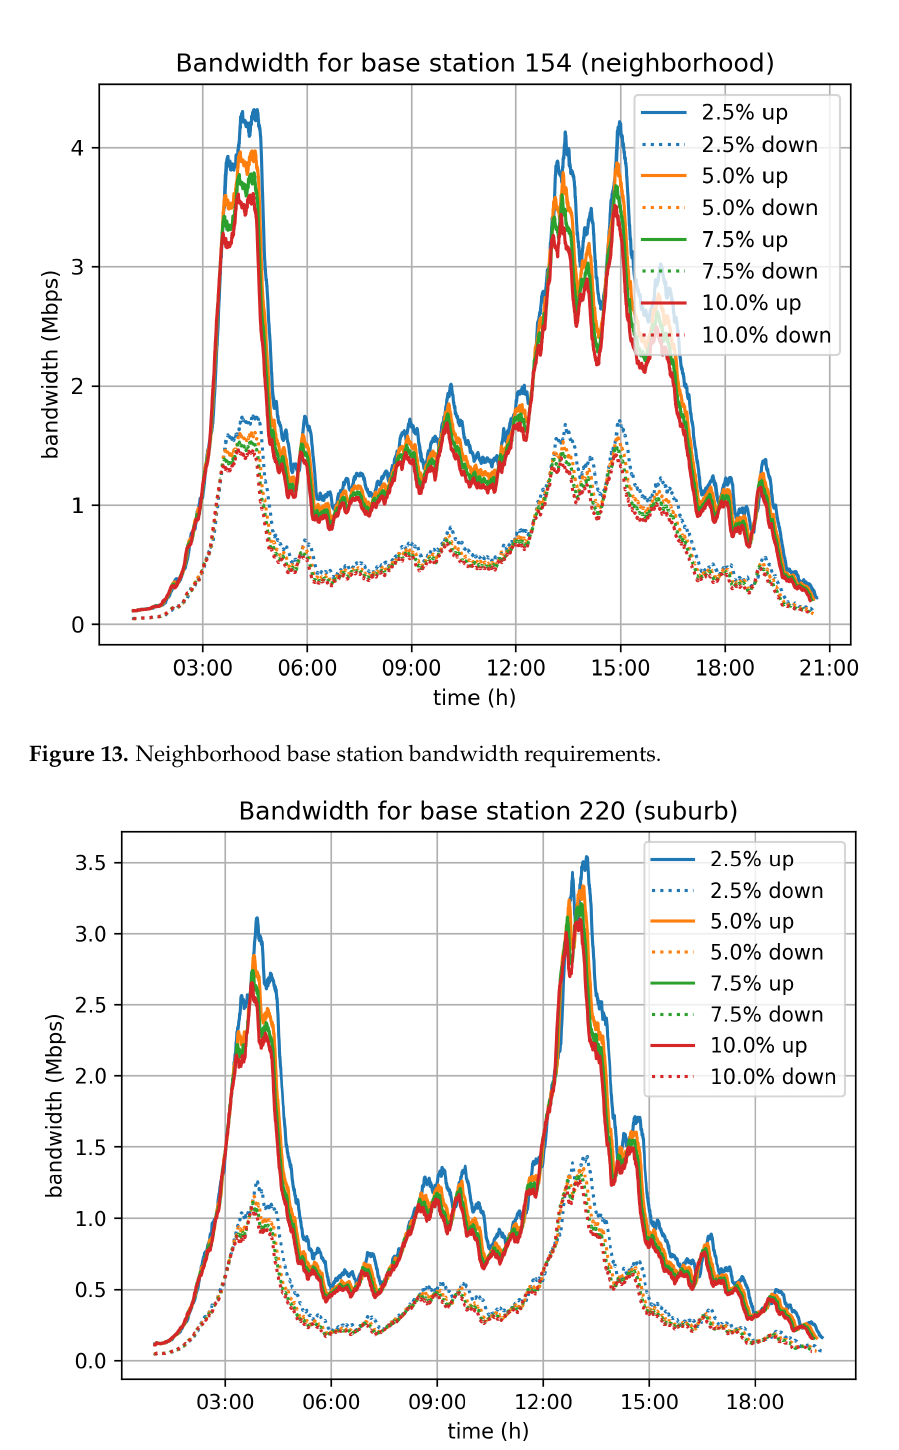
Figure 14. Suburbs center base station bandwidth